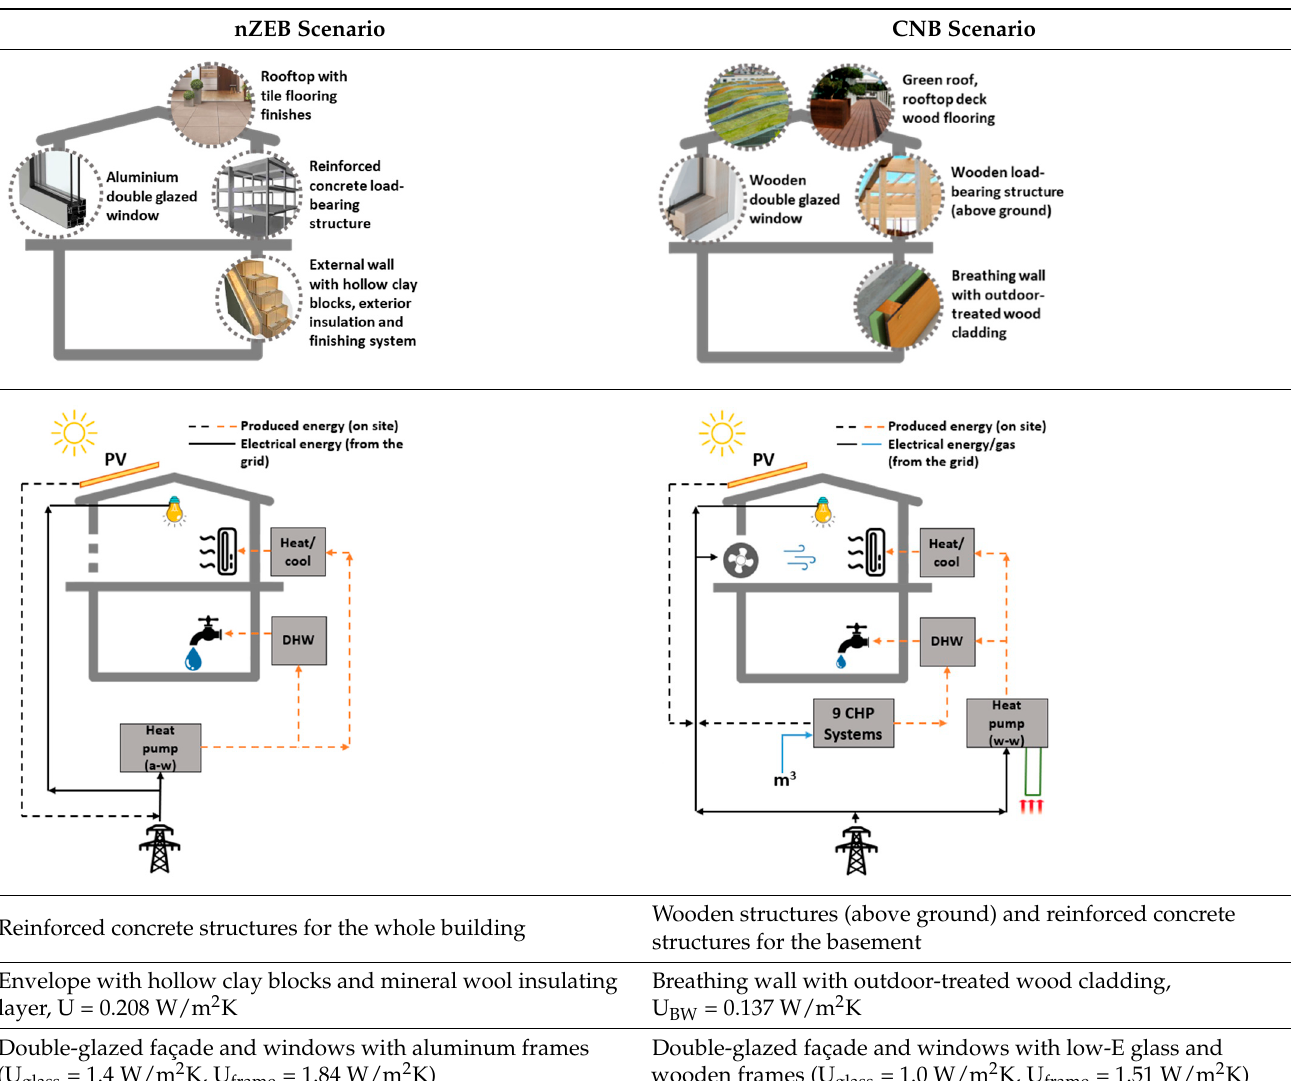
Table 2. Material and service system technologies considered in the nZEB and CNB scenarios.